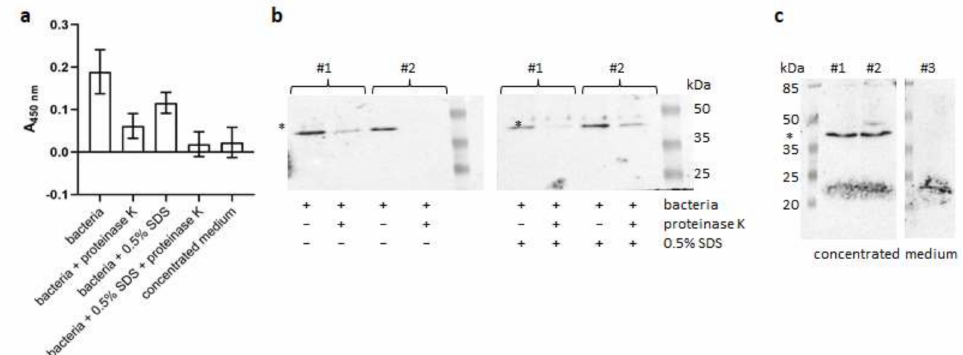
Figure 7. Identification of SgGAPDH forms produced by S. gordonii . SgGAPDH was visualized using ( a ) ELISA or ( b , c ) Western blotting. The protein was detected on the S. gordonii cell surface ( a , b ) or in the culture medium ( a , c ) using rabbit polyclonal anti-SgGAPDH antibodies and HRP-conjugated anti-rabbit IgG antibodies. The protein associated with the bacterial cell surface was examined in the native form or after treatment with proteinase K and / or SDS. Soluble secreted protein was detected in ~20 × concentrated culture medium. ( b , c ) SgGAPDH was examined in two independent samples (#1 and #2). ( c ) To examine putative cross-reactivity of anti-SgGAPDH antibodies, 20 × concentrated culture medium alone was also examined (sample #3). SgGAPDH protein is indicated by asterisks ( ∗